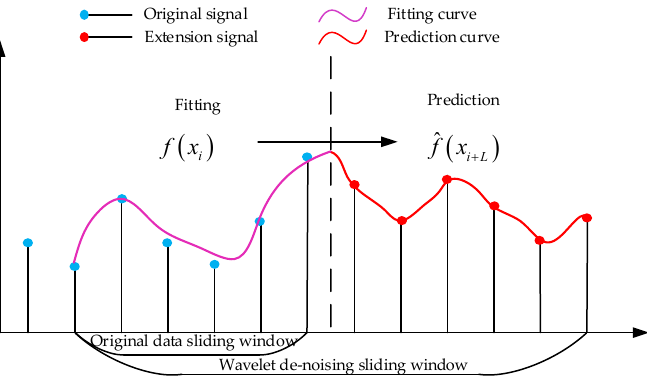
Figure 5. Function extension method.